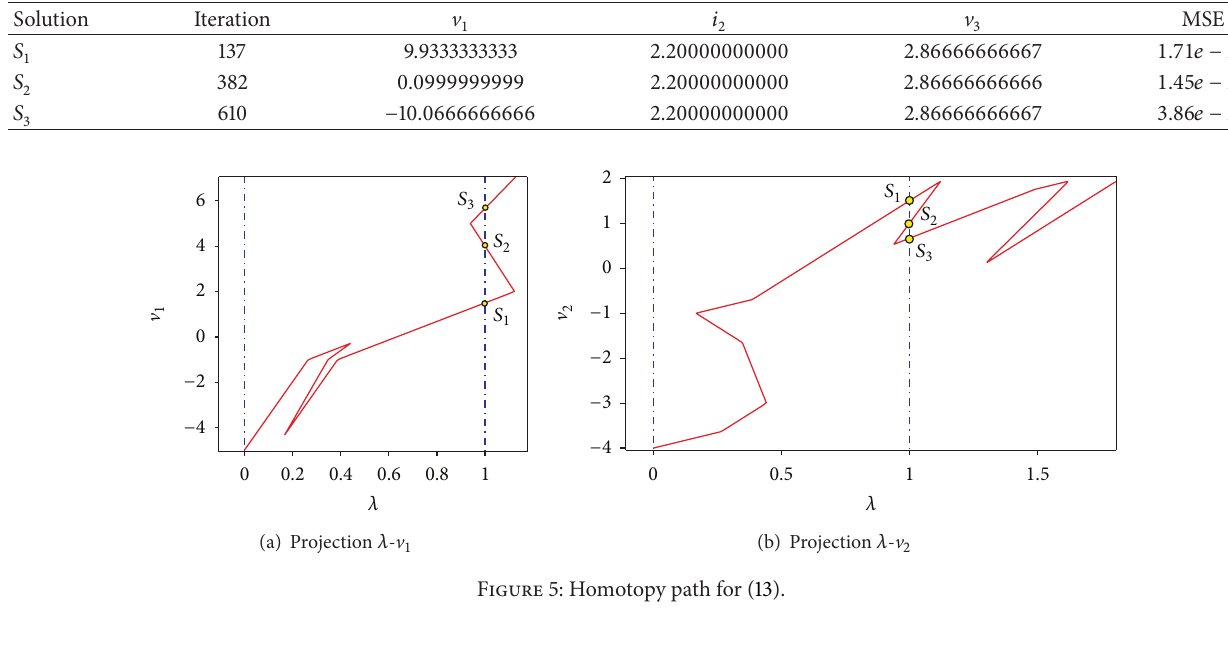
Table 2: Numerical solutions for (15).